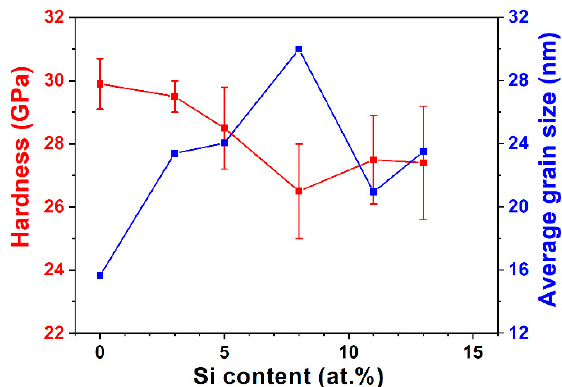
Figure 8. ( a ) Texture coefficient and ( b ) its relationship to the hardness of the TaWSiN films.